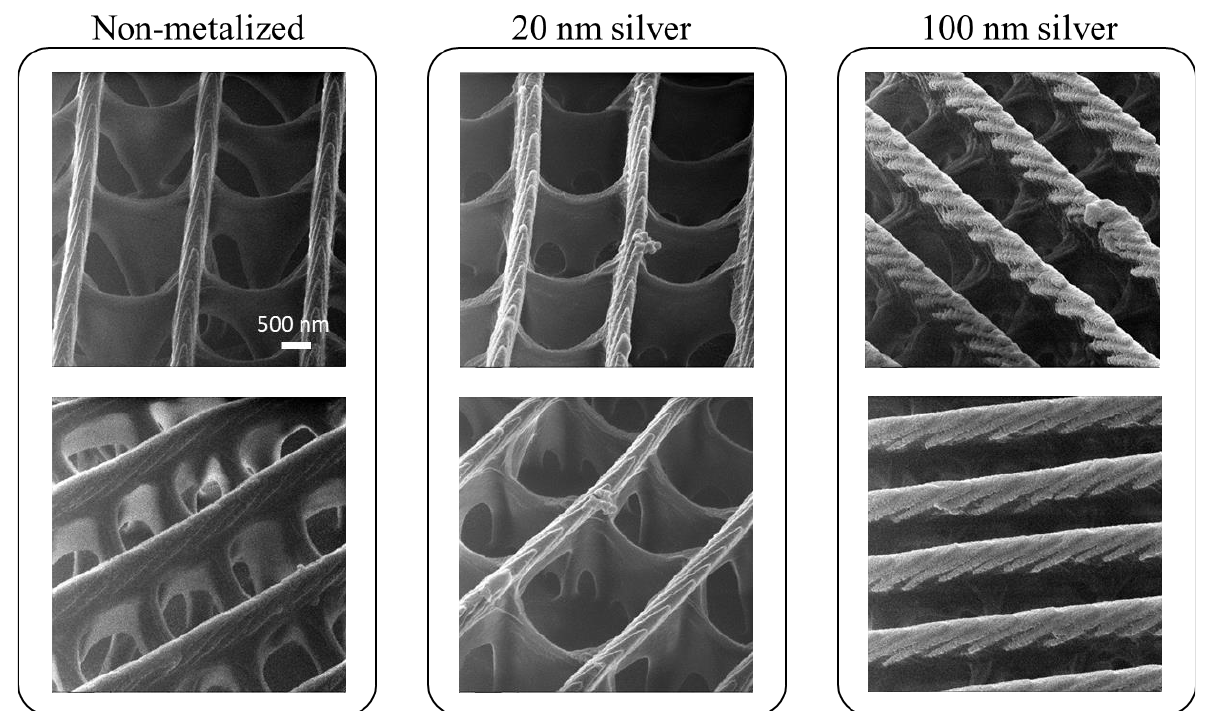
Figure 4. HIM images of chestnut scales from S. charonda with various silver deposition thicknesses. These were taken from different orientations and angles to facilitate the visualization of the three-dimensional hierarchical structures. The tilt angle is 45 degrees for all, expect for the top left image where it is 30 degrees. Scale bar: 500 nm.